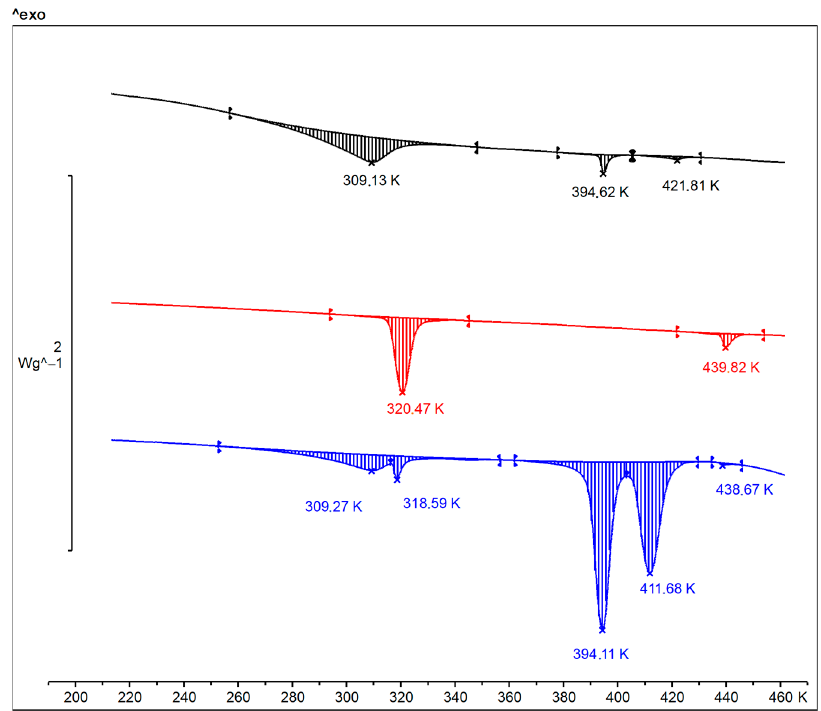
Figure 7. DSC thermogram of L-Methionine (black), synthesized Zn(Met) 2 (red) and crystallized Zn(Met) 2 (SO 4 ) x (blue) complexes during the first heating of samples.